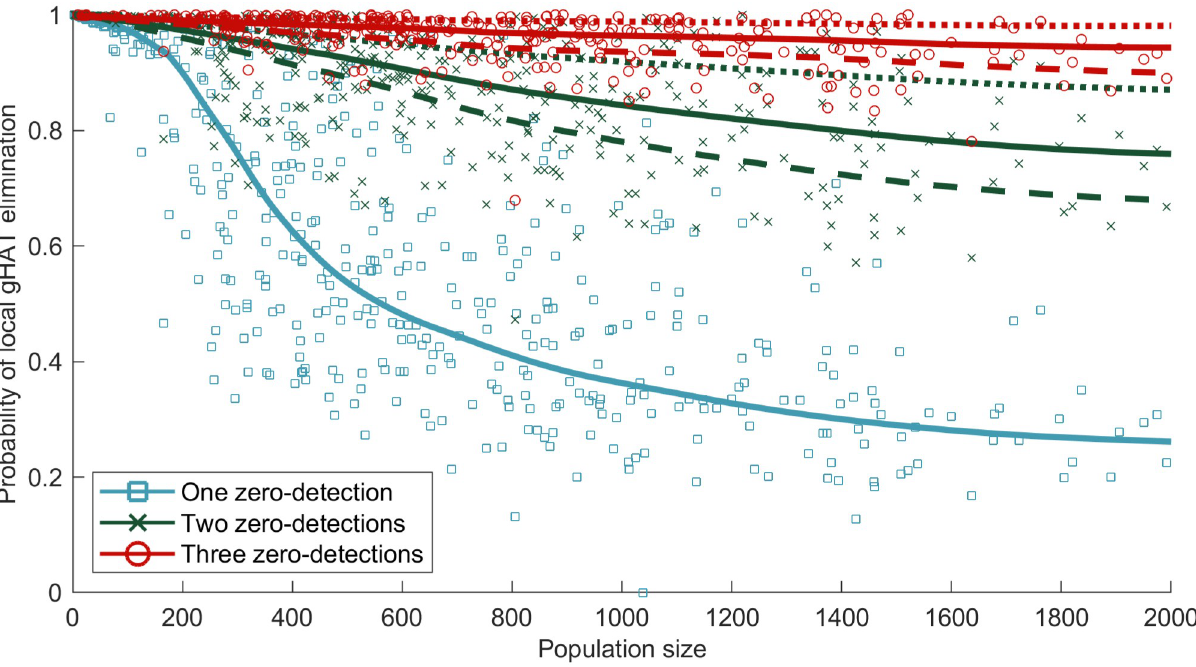
Fig 5. Probability of elimination in a settlement, given consecutive zero-detections with no detected passive cases. (A) Consecutive zero-detections means consecutive in the observed years of screenings, not necessarily in consecutive years, and with no passive cases detected in between. Each point represents the average from multiple simulations of individual settlements where the reported pattern of screenings is replayed. The points and solid lines assume a reporting rate of 26% [17], while the dashed and dotted lines show reporting rates of 0% and 100%, respectively. Sufficient simulations are used such that the confidence intervals are small (unobservable on the scale of this graph). Lines represent a weighted local regression fit. Active screenings where fewer than 20% of the population are assessed are excluded from our analysis due to the small sample sizes (alternative cut-offs of less than 10% and less than 50% are presented in Fig 13 in S1